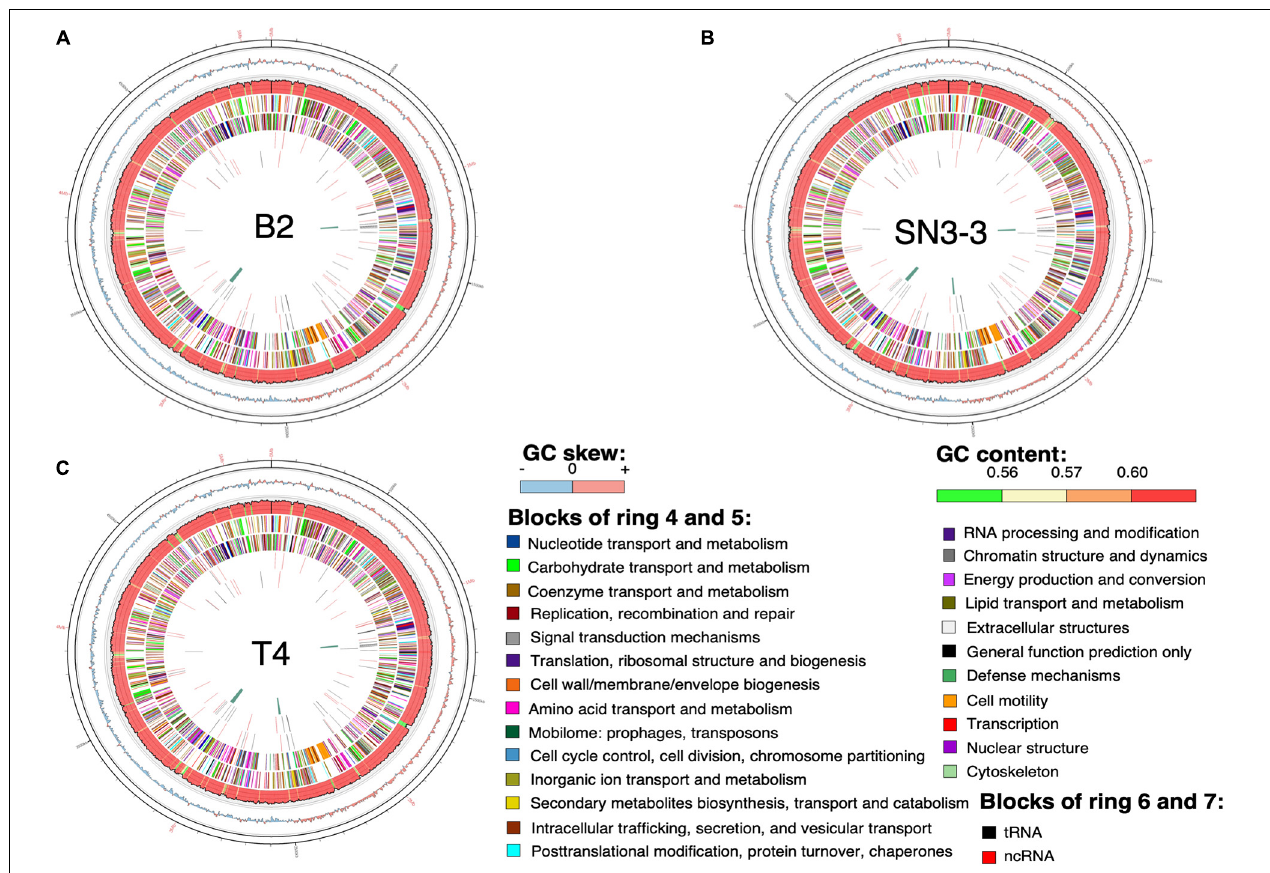
FIGURE 1 | Chromosome organization and genome annotation. (A–C) Overview of three assembled chromosomes and the distribution of genetic elements. Circles from outermost to innermost represent: (1) position, the grid is 100 kb; (2) GC skew with 2500-bp sliding widow and 2500-bp step; (3) GC content in the same sliding window and step size as GC skew; predicted protein-coding sequence (CDS) with known function (4) of the plus strand and (5) the minus strand; predicted RNA of (6) the plus strand and (7) the minus strand; (8) phage